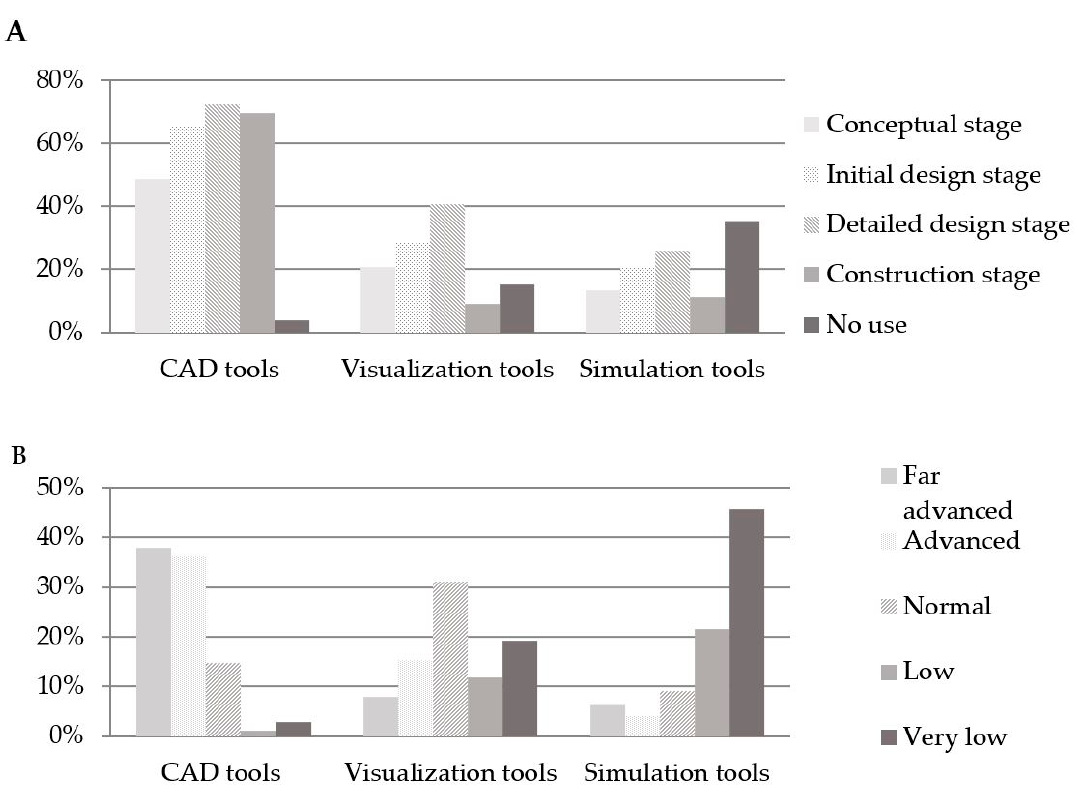
Figure 2. ( A ) In which stage of the design process do you use BPSTs? ( B ) What are your skills in the use of the following software? (Addressed to non-users and